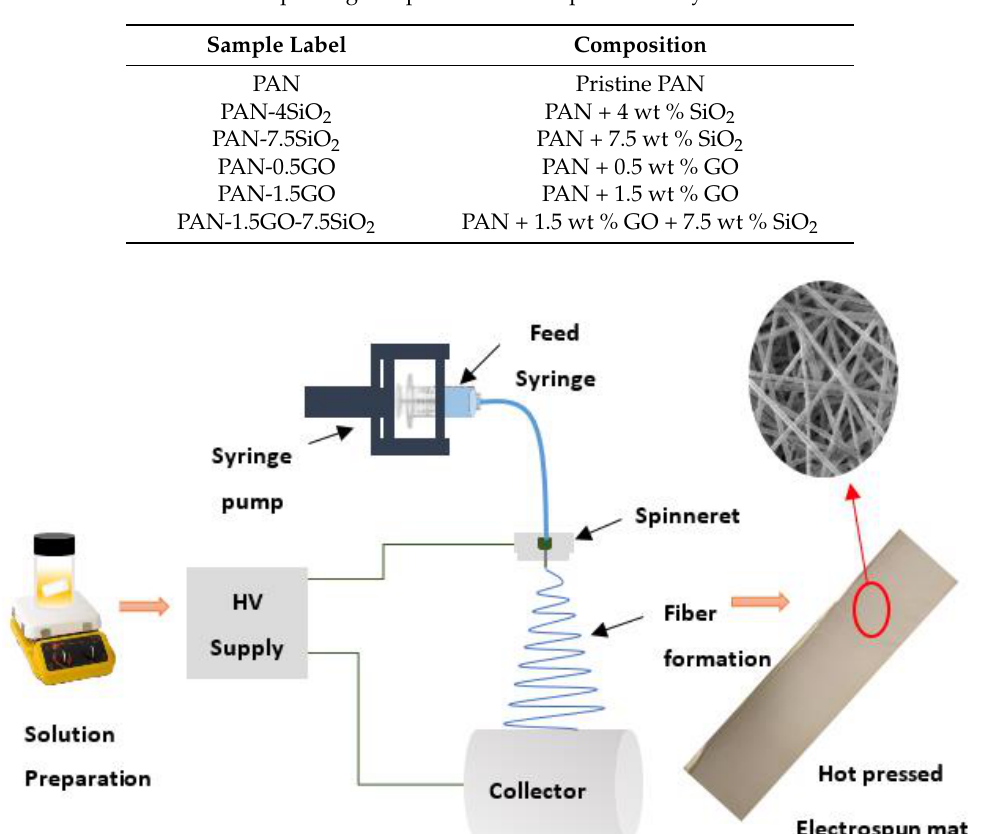
Figure 1. A schematic of electrospinning and PAN based membrane fabrication.